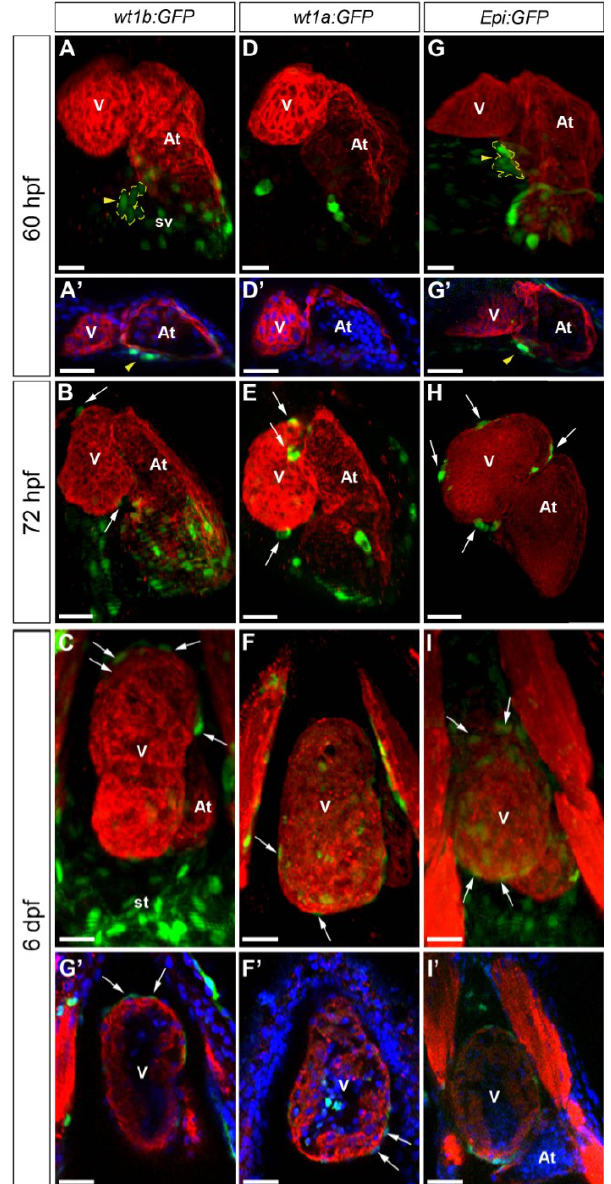
Figure 2. Validation of Wilms’ tumor 1 reporter lines for the study of epicardium development in the zebrafish. Whole mount immunofluorescence for myosin heavy chain (red) in hearts from the Tg( wt1b:GFP ), Tg( -6.8kbwt1a:GFP ) and Epi:GFP (Et( -26.5Hsa.WT1-1gata2 : EGFP ) cn1 ) zebrafish lines at the developmental stages are indicated on the left. Endogenous GFP expression is shown in green. In some panels, nuclear DAPI staining is shown in blue. ( A – I ) 3D projections. Ventral views are shown; anterior is to the top. ( A’ – I’ ) Confocal sections of the whole mount hearts shown in A–I. Arrowheads mark the PE, which is additionally demarcated by a dotted yellow line; arrows mark epicardial cells. ( A – C ) Tg( wt1b:GFP ) labels a few PE cells and epicardial cells and strongly marks the sinus venosus and septum transversum. ( D – F ) GFP expression in Tg( -6.8kbwt1a:GFP ) labels epicardial cells, but the PE is not clearly visible. ( G – I ) Epi:GFP labels the sinus venosus and septum transversum, as well as PE clusters and epicardial cells. At, atrium; st, septum transversum; sv, sinus venosus; V, ventricle. Scale bars: 30